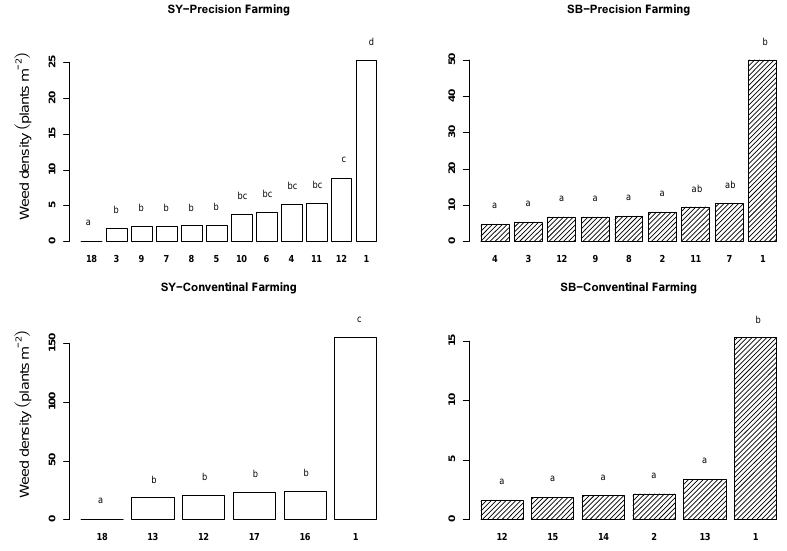
Figure 1. Weed density in sugar beet (SB) and soybean (SY) measured directly after last weed hoeing using automatic steering technologies and conventional weed control methods; soybean experiments were conducted at Kleinhohenheim and March-Buchheim in 2013 and Kleinhohenheim and Ihinger Hof in 2014; sugar beet experiments were carried out at Gützingen, Ihinger Hof, Heidfeldhof and Renningen in 2014. Precision farming technologies were tested in SB and SY in 2014. Data of the conventional weed control of different locations were averaged. Mean values within the same column followed by an identical letter do not differ statistically based on the Tukey HSD test ( p ≤